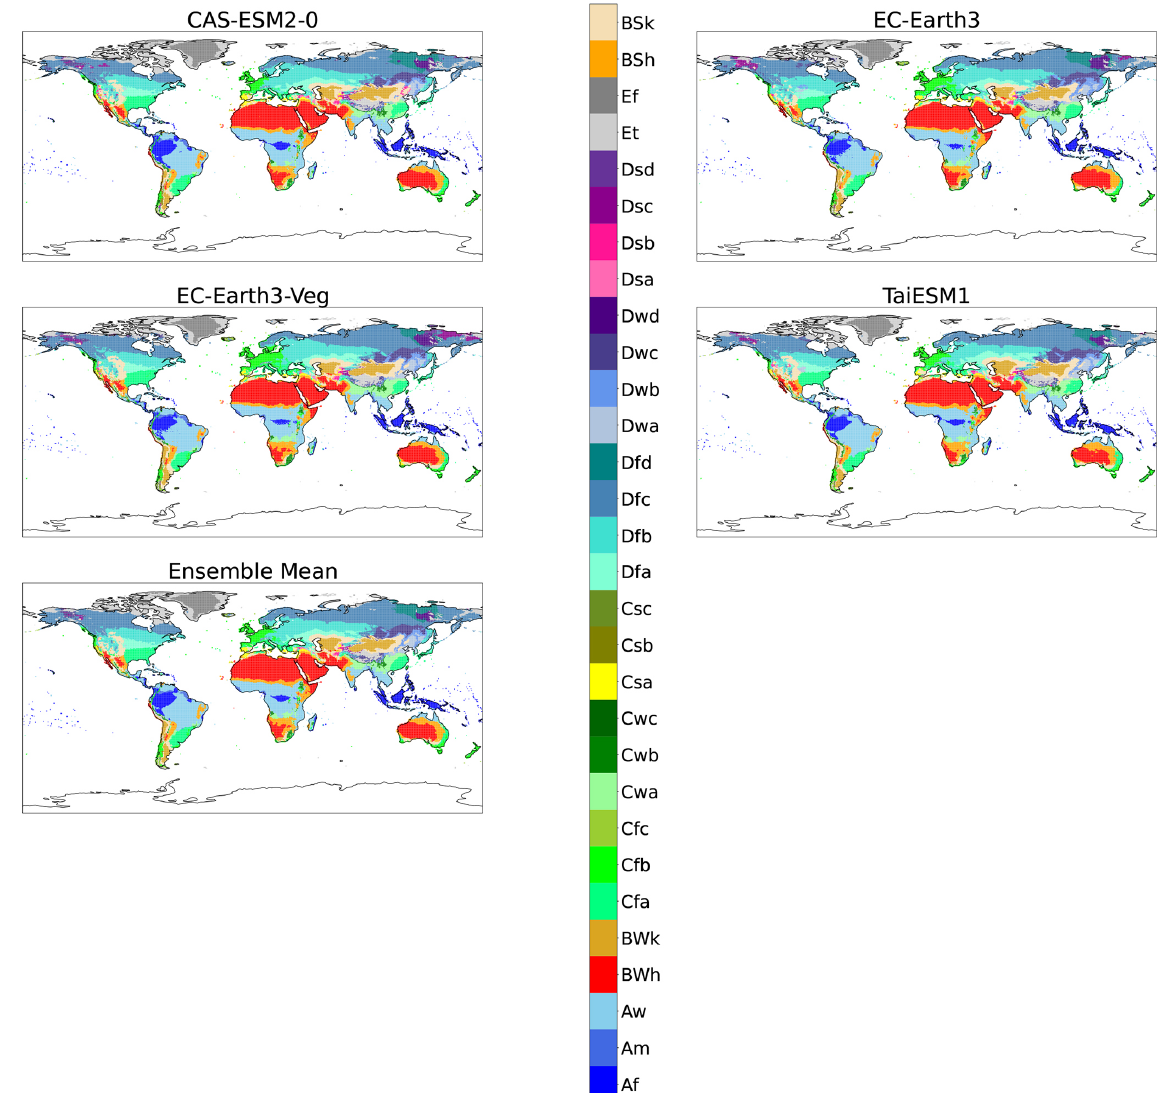
Figure A2. Maps of KG classifications for each model at + 1K with anomaly